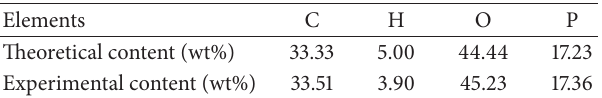
Figure 2: 1 H-NMR spectrum of PEPA. Table 1: The experimental and theoretical elemental analysis results of